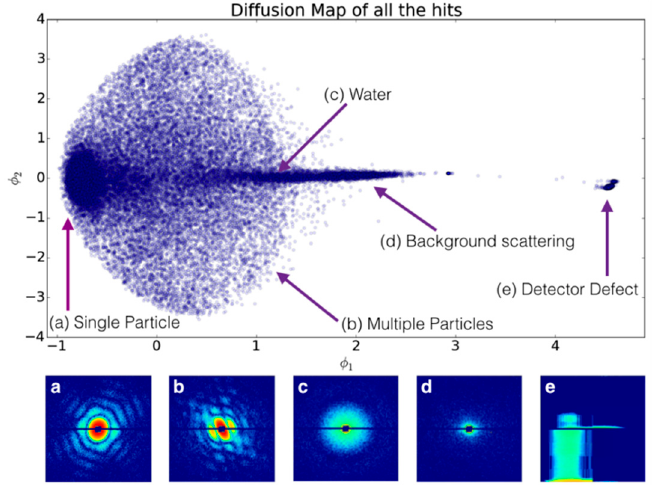
Figure 9. Diffusion map analysis of all hits. Large data sets were reduced to single-particle hit patterns. ( a ) Single-particle hit; ( b ) multiple-particle hit; ( c ) water diffraction that may contain contaminant residue from samples and buffer solutions; ( d ) background diffraction from detector; ( e ) detector defect pattern. (reproduced with permission from [197]. Copyright Springer Nature, 2017).